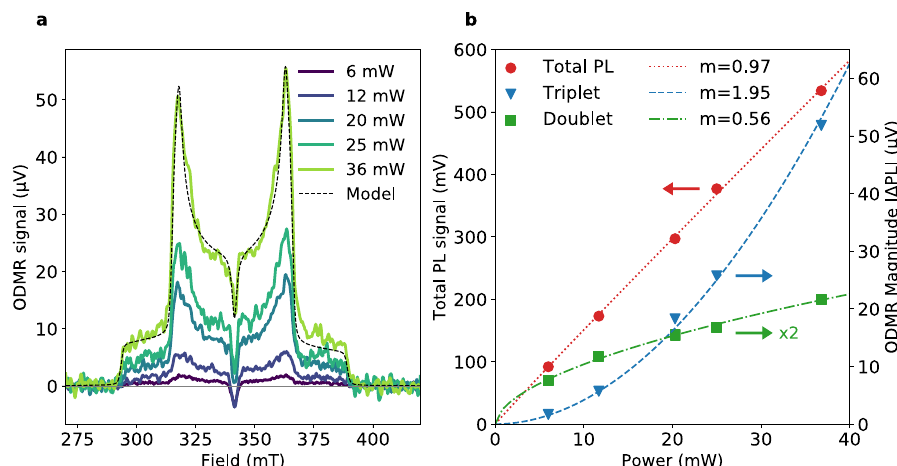
Fig. 5 ODMR of TTBP. a ODMR of 100% TTBP fi lm at 50 K using a 532 nm CW laser excitation at a range of excitation densities, labelled by the total laser power incident on the microwave cavity. The microwaves were modulated in a square wave at f M = 315 Hz and data collected using an avalanche photodiode and lock-in ampli fi er. The in-phase signal is shown, and the out-of-phase signal was negligible in comparison. Black dotted line shows a simulation for a triplet signal performed with EasySpin 51 + a Lorentzian radical signal, with the same zero- fi eld splitting parameters for the triplet as used for the trESR simulation ( D = 47.9 mT, E = 1.0 mT) and a linewidth of 1.3 mT. b Power dependence of total PL and ODMR (triplet and doublet features) for the same powers as used in a . Total PL is in red, left axis, circles; ODMR triplet peak Δ PL (366 mT) is in blue, right axis, triangles; doublet due to radicals (342 mT) is in green, right axis, squares. The lines are fi ts of PL or Δ PL ∝ ( incident power ) m with m = 0.97 for the total PL (red dotted line), m = 1.95 for the triplet ODMR peak (blue dashed line), and m = 0.56 for the ODMR doublet signal (green dash-dot line). The fi ts demonstrate that they are in the linear, quadratic, and sub-linear regimes,